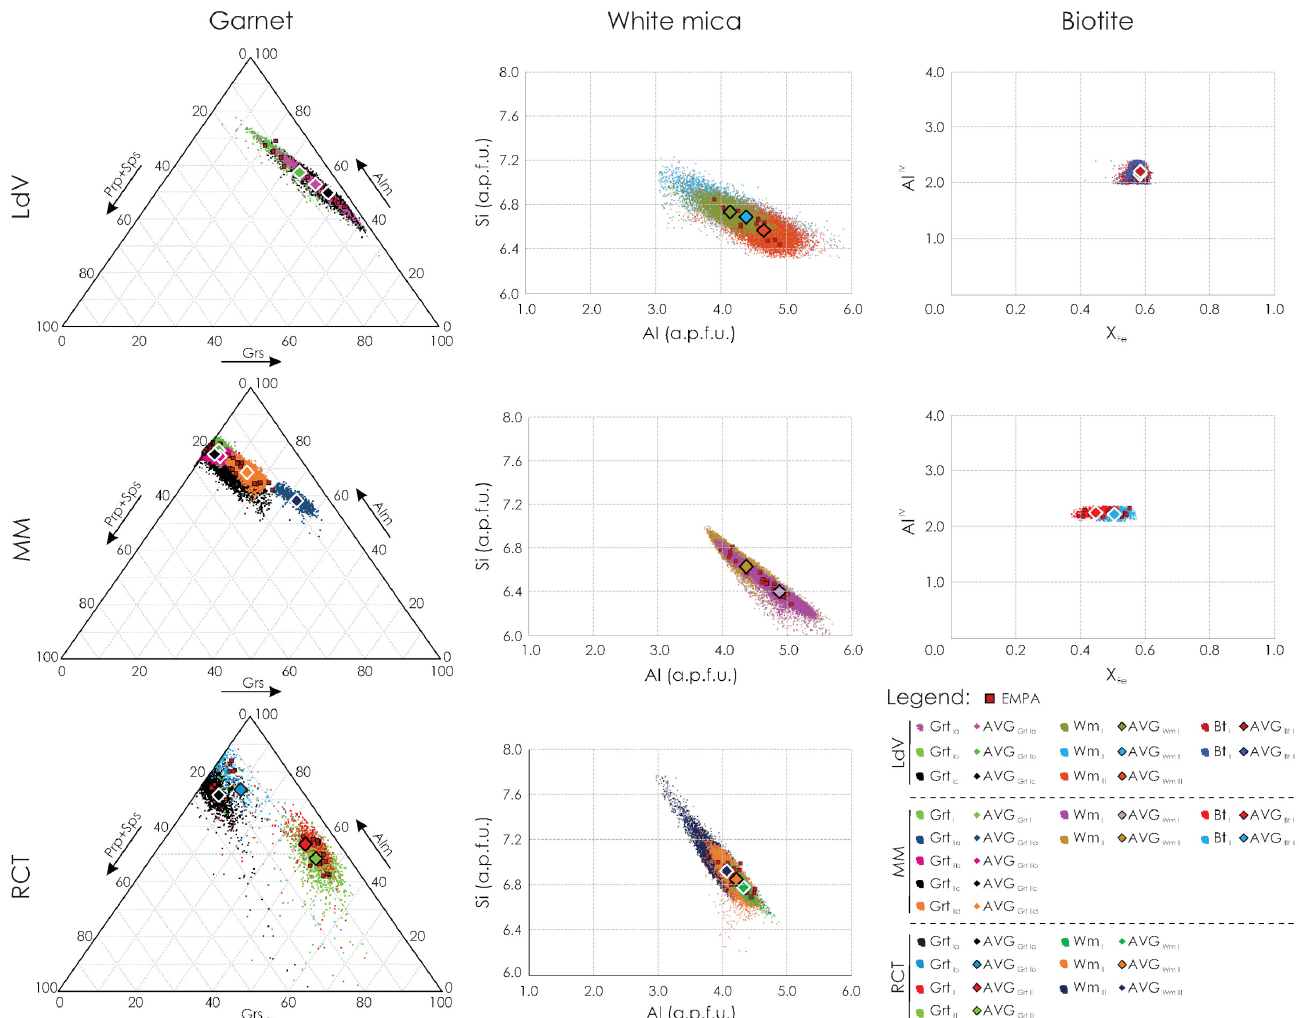
Figure 12. Mineral compositions obtained with Q-XRMA for the different generations of garnet, white mica, and biotite from the three investigated localities. AVG refers to the mean compositional values; EMPA = electron microprobe